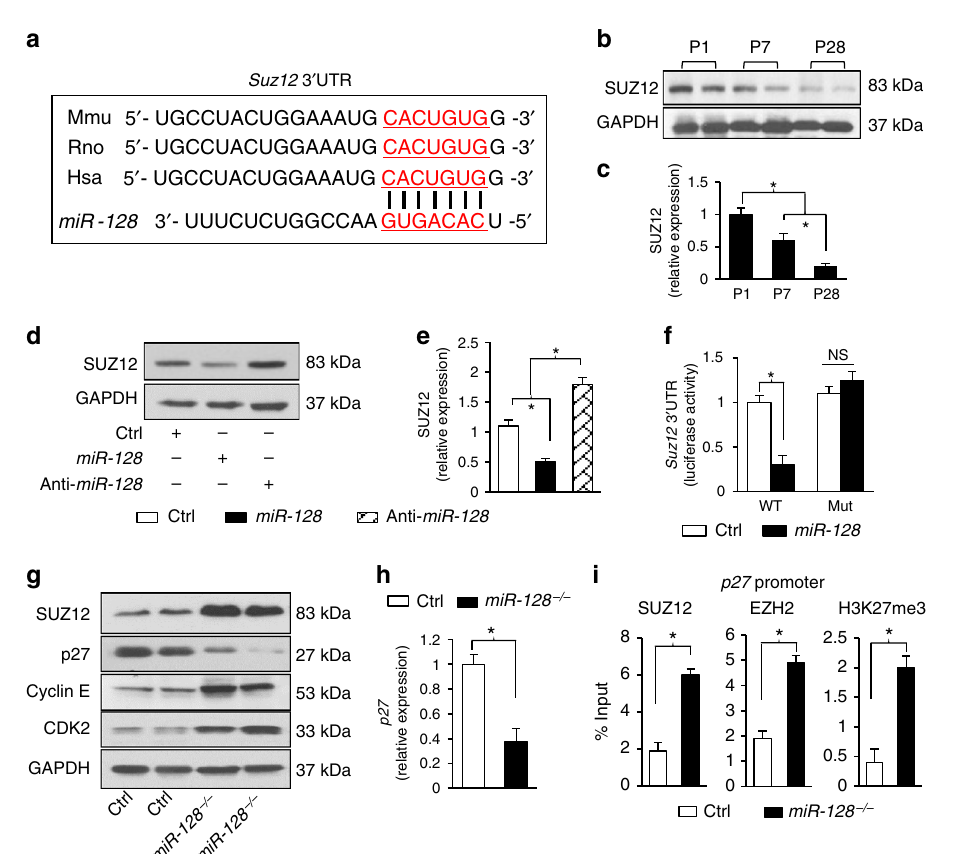
Fig. 4 MiR-128 deletion is associated with activation of cell cycle-related genes. a The predicted conserved target site of miR-128 in the 3 ′ UTR of Suz12 from different species. b , c Western blot analysis of SUZ12 expression in mouse hearts at P1, P7, and P28 ( n = 5). d , e Western blot analysis of SUZ12 expression in neonatal CMs treated with either vehicle (Ctrl), miR-128 mimic ( miR-128 ) or miR-128 inhibitor (Anti- miR-128 ) ( n = 3). f Luciferase reporter assay for wild- type (WT) and mutant Suz12 3 ′ UTR (Mut) in cells treated with either vehicle (Ctrl) or miR-128 mimic ( miR-128 ) ( n = 3). g Western blot assay for cell cycle- related protein expression in control ( miR-128 fl / fl ), and miR-128 − / − ( Nkx2.5 Cre ; miR-128 fl / fl ) hearts at P7 ( n = 5). h Quanti fi cation data of p27 mRNA levels in Ctrl and miR-128 − / − hearts by qPCR ( n = 5). i Comparison of SUZ12, EZH2, and H3K27me3 enrichment on the p27 promoter by ChIP-qPCR ( n = 5). Statistical signi fi cance was calculated using ANOVA in c , e and Student ’ s t -test in f , h , and i . Data are represented as means ± SEM. * P < 0.05.